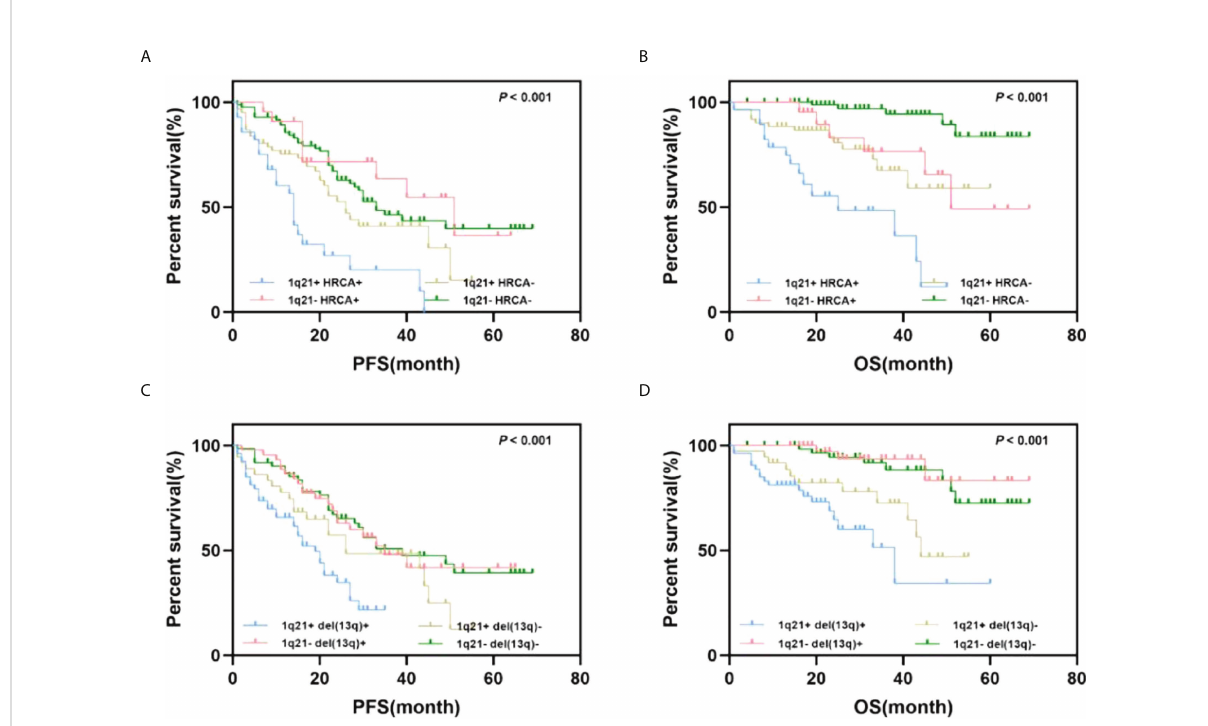
FIGURE 3 Impact of 1q21 gain coexisting with other cytogenetics on PFS and OS. (A, B) Kaplan – Meier curves are shown for PFS and OS for patients with or without 1q21 gain and high-risk cytogenetics abnormalities. (C, D) Kaplan – Meier curves are shown for PFS and OS for patients with or without 1q21 gain and